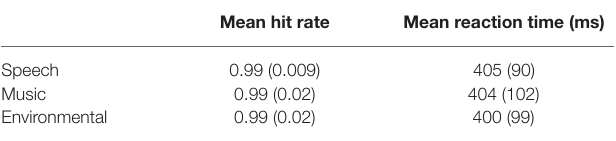
TABLE 1 | Detection condition.